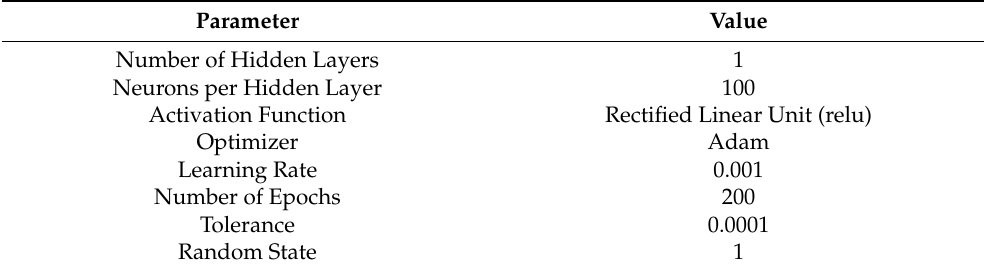
Table 5. Parameters values used for the artificial neural network classifier algorithm in scikit-learn. All values are the default options except for the random state.